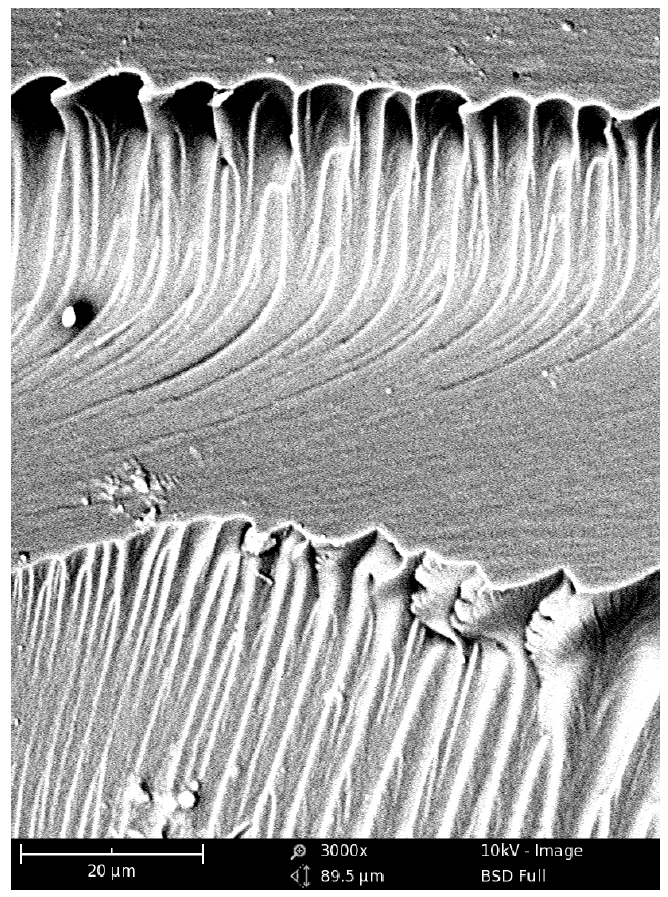
Figure 6. The SEM image of the Bis-GMA–TEGDMA (80:20) fractured surface; a scale bar represents 20 μ m.